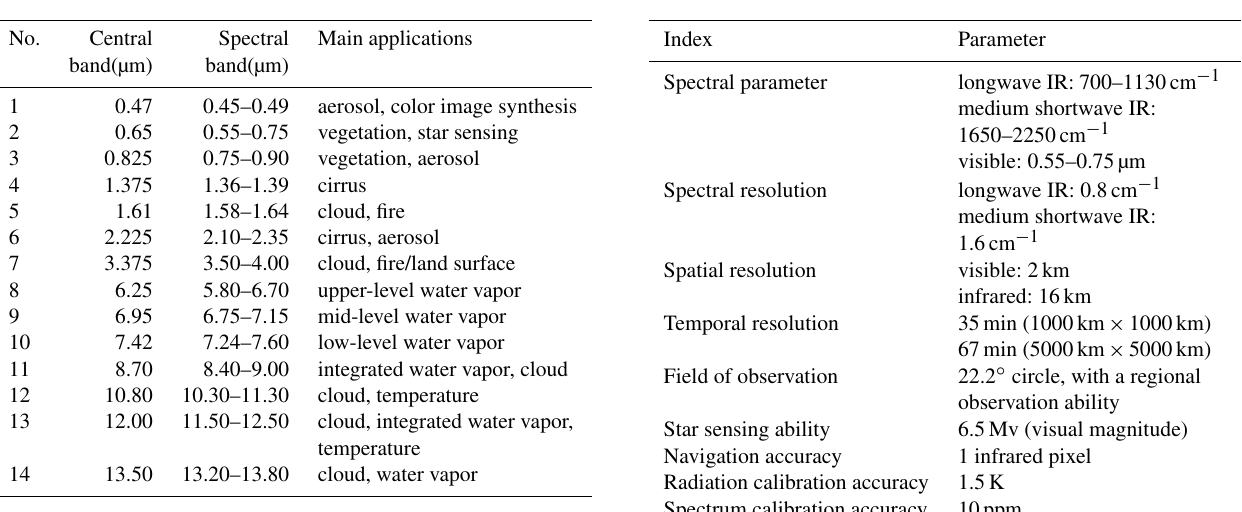
Table 2. Spectral configuration of AGRI.